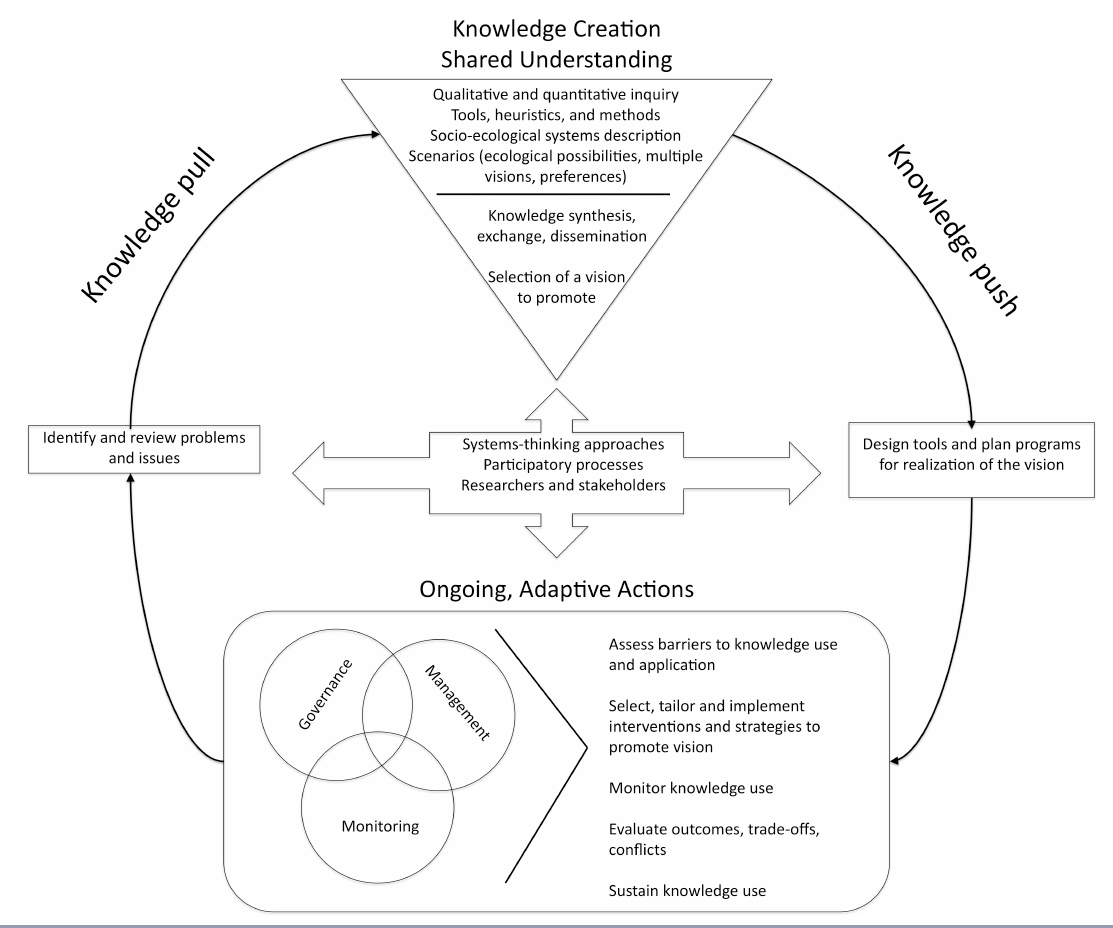
Fig. 3. A knowledge-to-action process for EAH, adapted from Graham (2006) and Waltner-Toews and Kay (2005). Drivers of the cycle may be initiated when: (1) a problem is identified, and there is a need for new knowledge to address the issue (knowledge pull); (2) new knowledge is deemed useful for management, and researchers wish to inform leaders or decision makers (knowledge push); (3) a mutual push–pull situation. Participatory research designs are vital in that they enable the coconstruction of knowledge, promote awareness and capacity building among the actors involved, and foster the adoption of research evidence in ways that respect cultural values and social norms. Systems thinking approaches help navigate uncertain and complex situations and integrate social and ecological